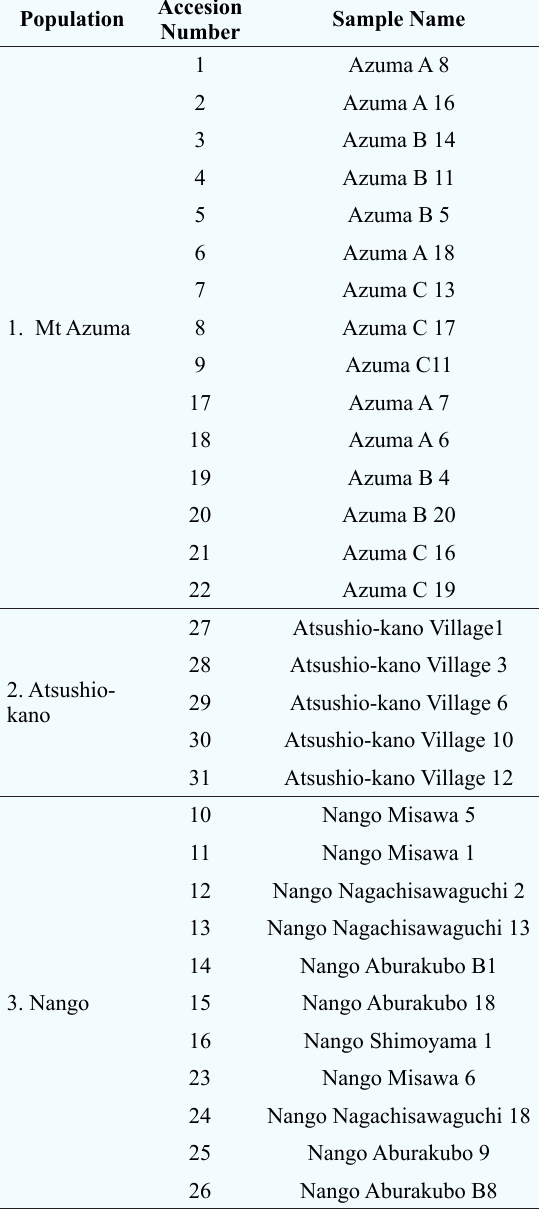
Table 1. Sample Name Collected in Fukushima